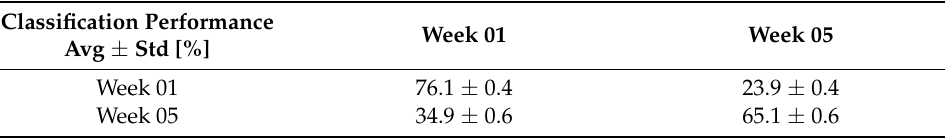
Table 4. Binary classification of cells from week 1 and 5 using logistic regression trained and tested with cells from all